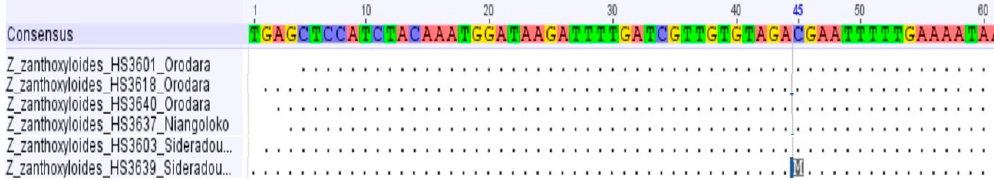
Figure 7. ITS alignment of Z. zanthoxyloides (partly).